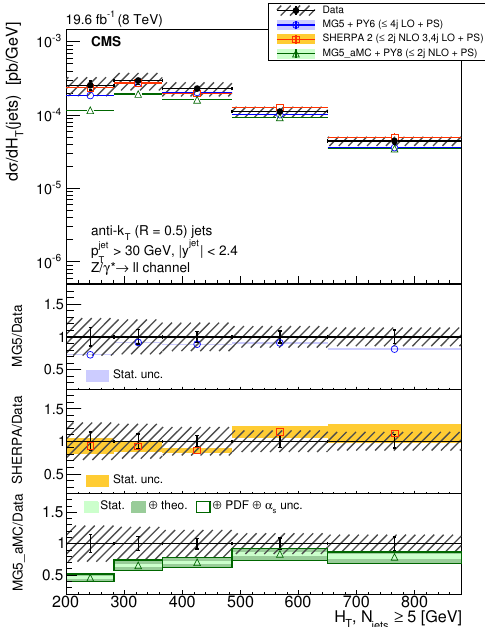
Figure 17 . The di(cid:11)erential cross section for Z ( ! ‘‘ ) + jets production measured as a function of H T for N jets (cid:21) 5 compared to the predictions calculated with MadGraph 5 + pythia 6, sherpa 2, and mg5 a mc + pythia 8. The lower panels show the ratios of the theoretical predictions to the measurements. Error bars around the experimental points show the statistical uncertainty, while the cross-hatched bands indicate the statistical and systematic uncertainties added in quadrature. The boxes around the mg5 a mc + pythia 8 to measurement ratio represent the uncertainty on the prediction, including statistical, theoretical (from scale variations), and PDF uncertainties. The dark green area represents the statistical and theoretical uncertainties only, while the light green area represents the statistical uncertainty